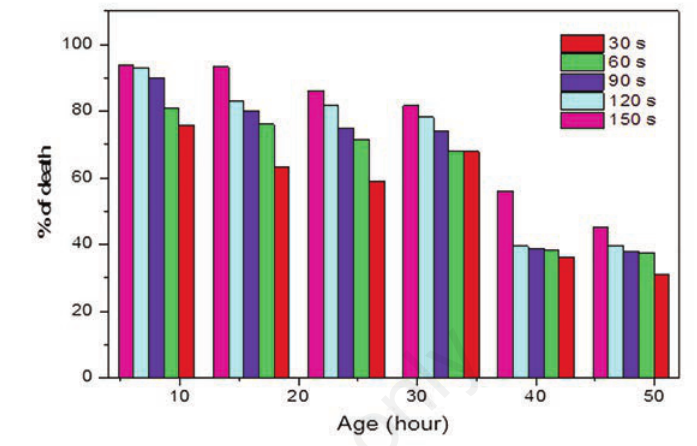
Figure 3. Bacterial death rate at each biofilm age.